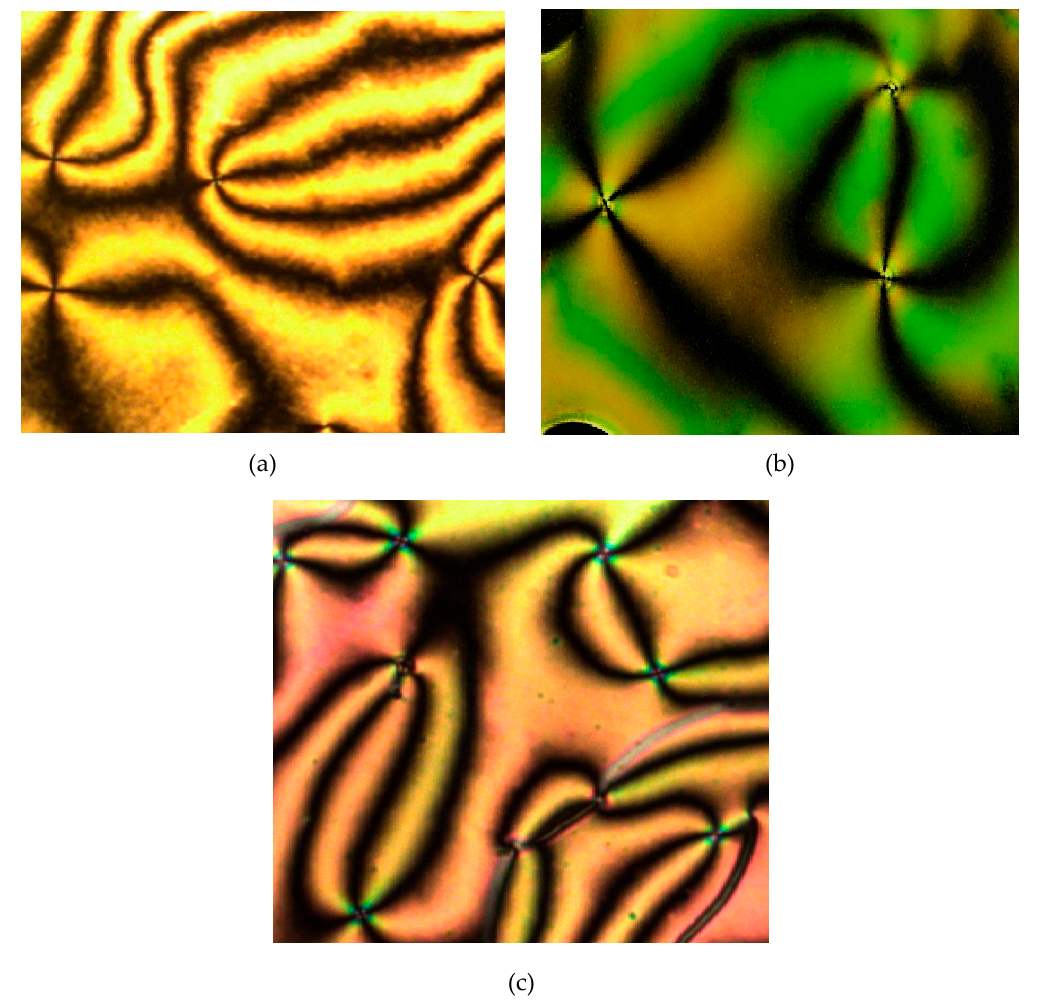
Figure 12. The optical photomicrographs of compounds 4g – i in the cooling cycle showing the thread- like schlieren texture of nematic phase: ( a ) 4g at 210.33 °C, ( b ) 4h at 211.45 °C, and ( c ) 4i at198.67 °C (Magnification of 20 × 0.25).